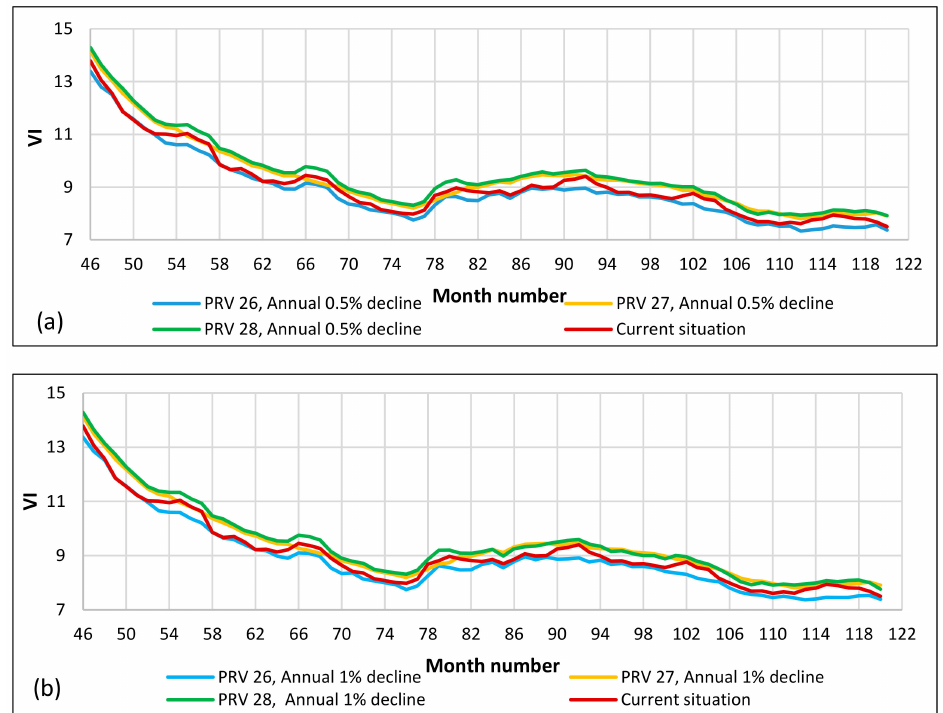
Figure 15. E ff ects of reducing the pressure of the PRV valves and ( a ) annual 0.5% decline of the per capita demand, ( b ) annual 1% decline of the per capita demand.